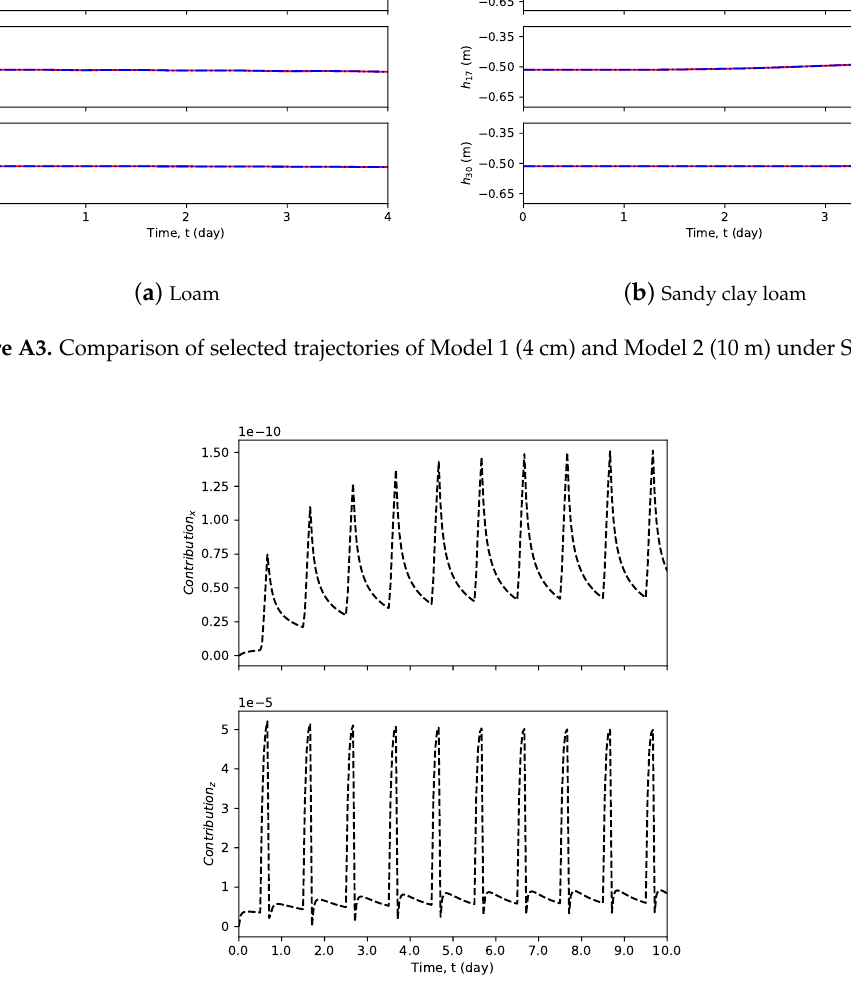
Figure A4. Trajectories of contributions of states in x and z directions to the system’s